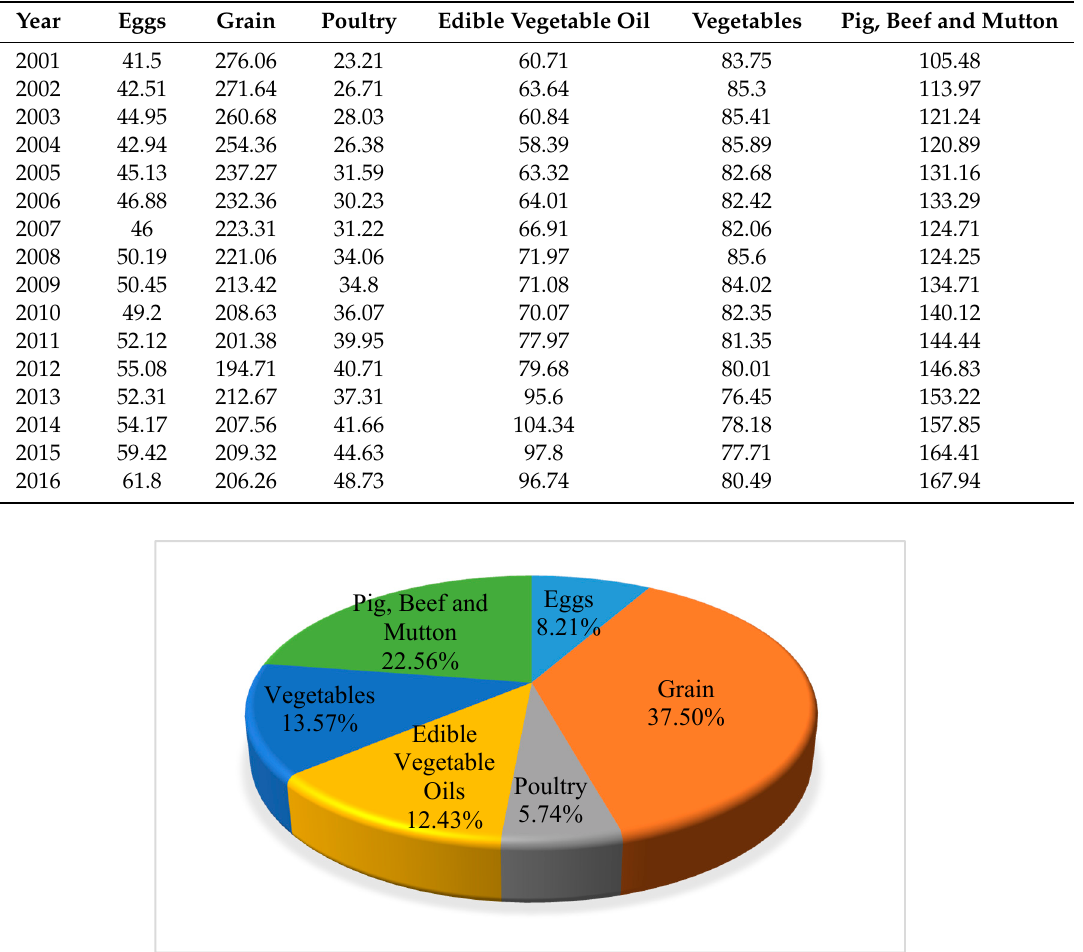
Figure 4. The proportion of water footprint consumed by each type of food in China.